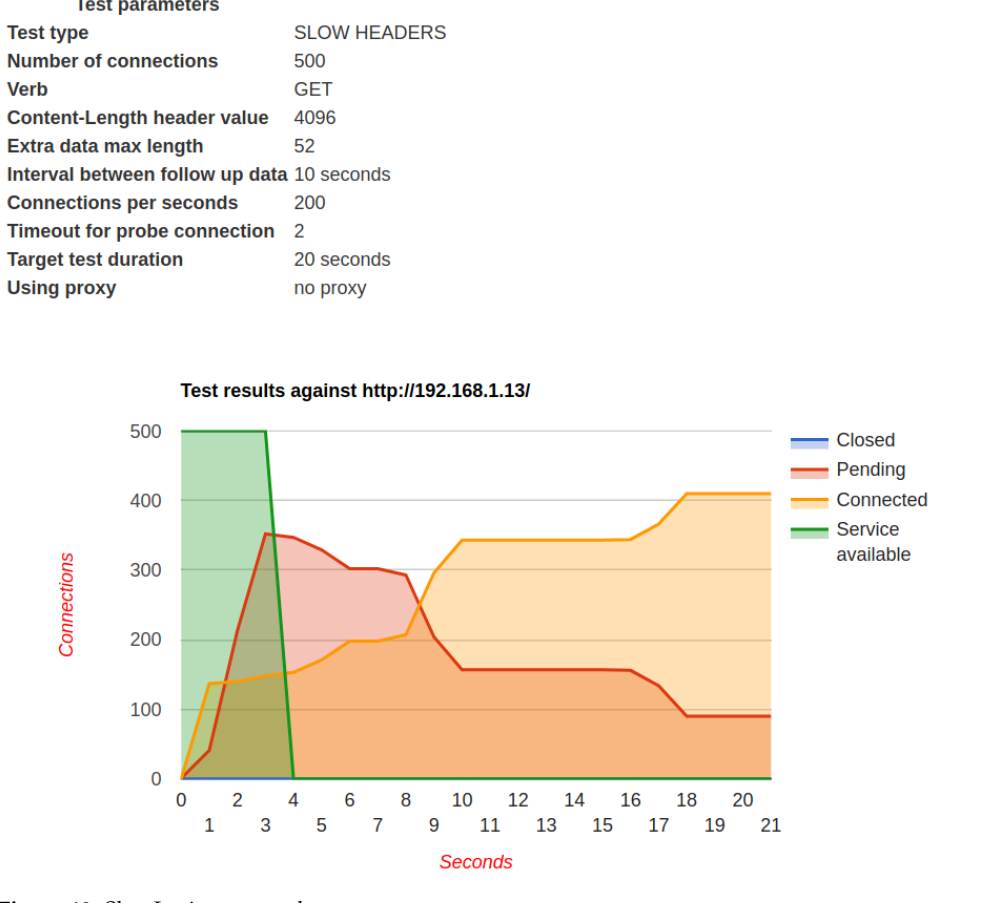
Figure 12. SlowLoris